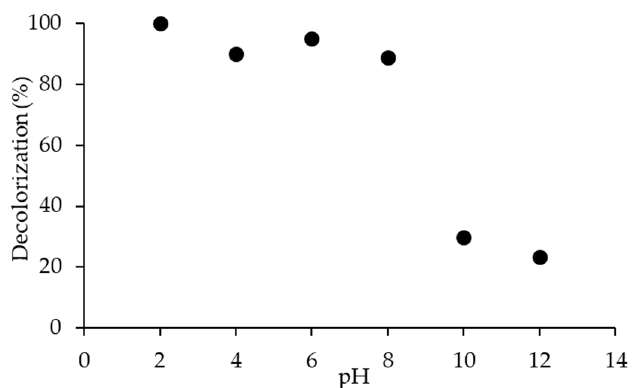
Figure 10. E ff ect of pH on the decolorization of RB5 dye using photocatalyst 20N–TiO 2 Figure 10. Effect of pH on the decolorization of RB5 dye using photocatalyst 20N–TiO 2 -300.